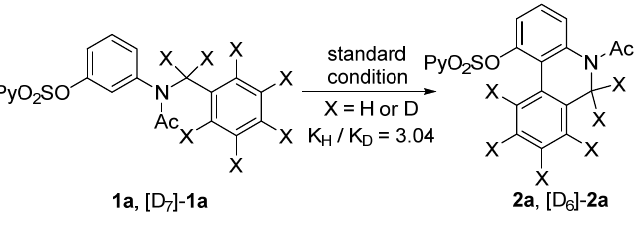
Figure 3. KIE experiment.